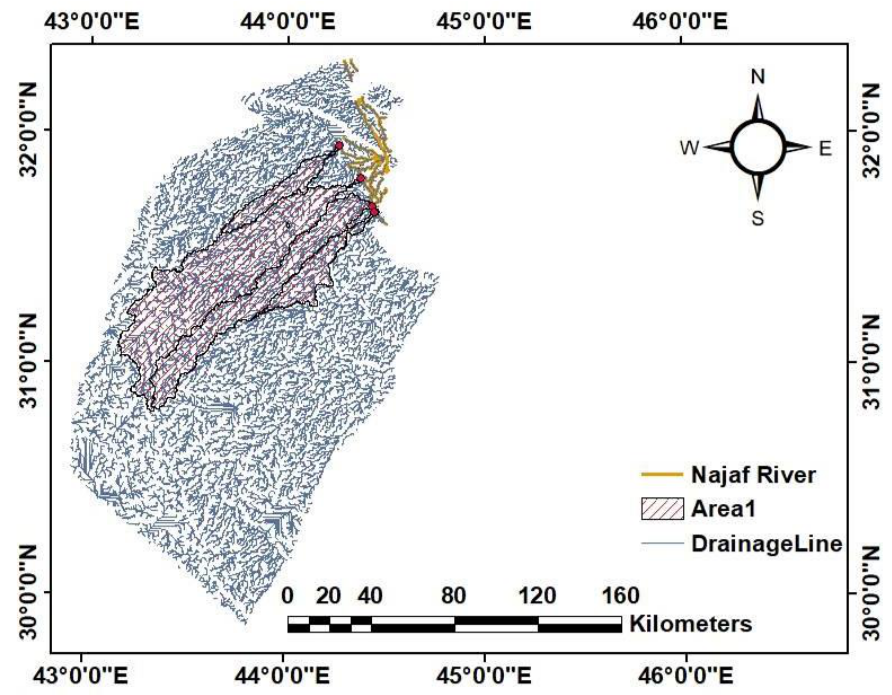
Fig. 4. The outlet points and basins of the case study